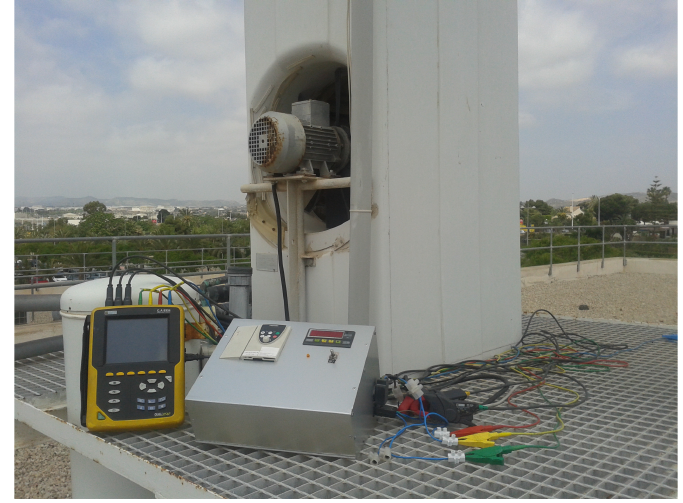
Figure 3. Power analyzer and frequency shifter at the pilot plant.